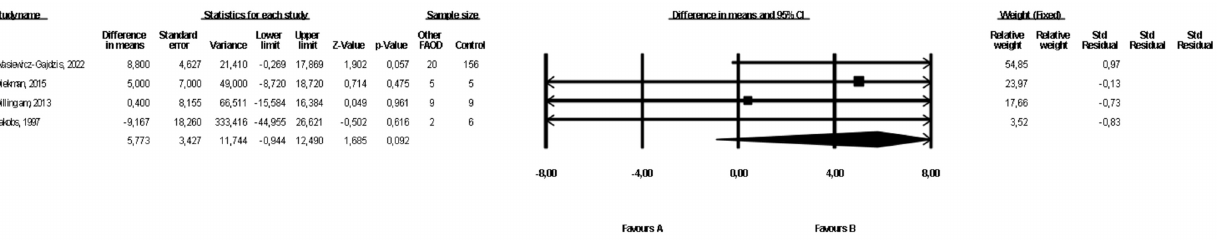
Figure 7. Forest plot—comparison of BMI in patients with FAOD other than MCAD vs. controls [14,15,17,18,20,25]. Figure 6. Forest plot—comparison of body weight in patients with FAOD other than MCAD vs. controls [16,18,22].